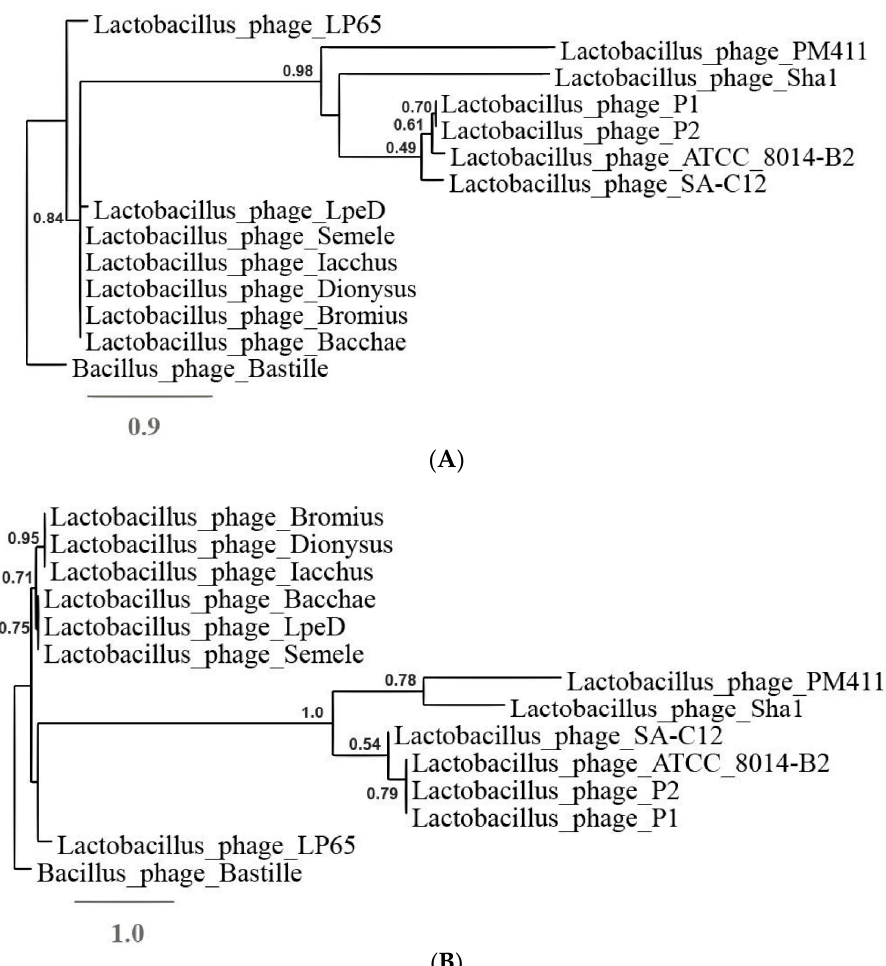
Figure 3. Phylogenetic trees for phages Semele, Bacchae, Dionysus, Iacchus and Bromius and other Lactobacillus phages yielding average similarity of at least 0.05 or higher with Gegenees. ( A ) Tree constructed using the major capsid proteins, ( B ) tree constructed using the large subunit terminases. The amino acid sequences were compared with the “One Click mode” (http://phylogeny. Lirmm.fr/). Bacillus phage Bastille proteins were used as outliers.